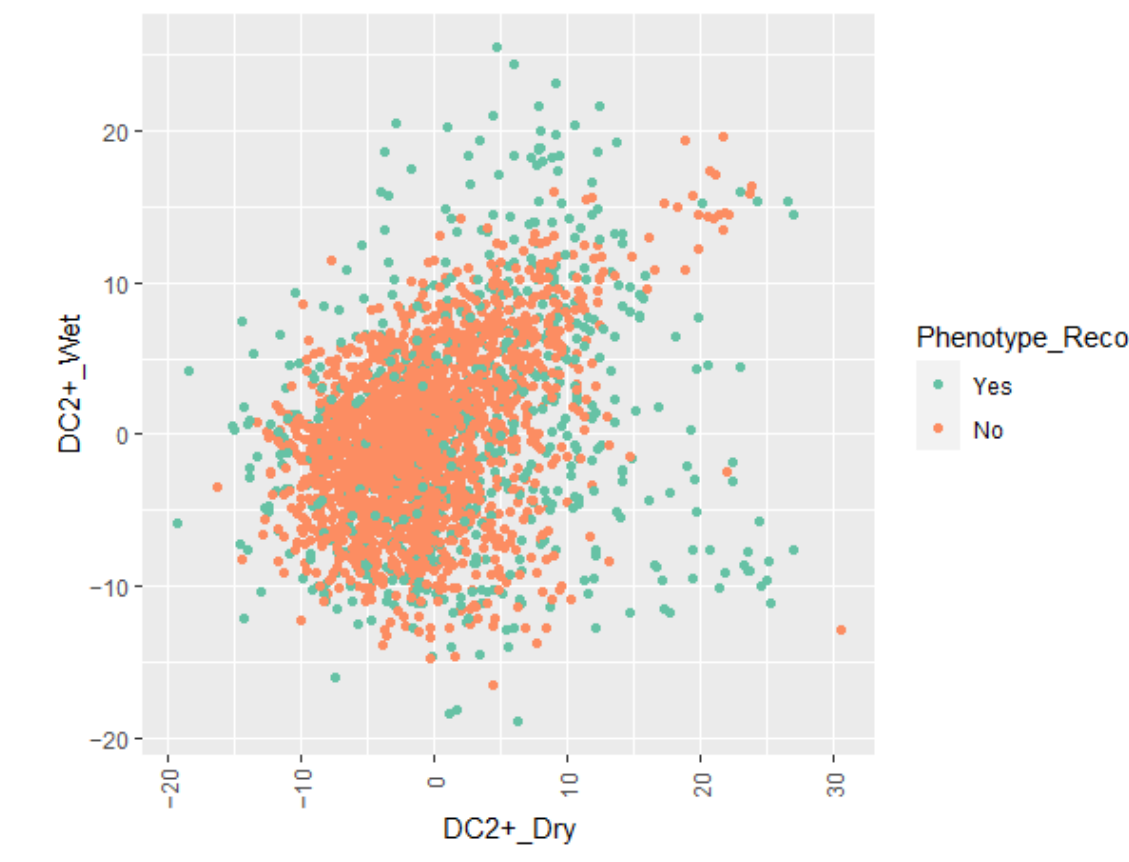
into lactation status (lactating/non-lactating) with standard errors in parenthesis.